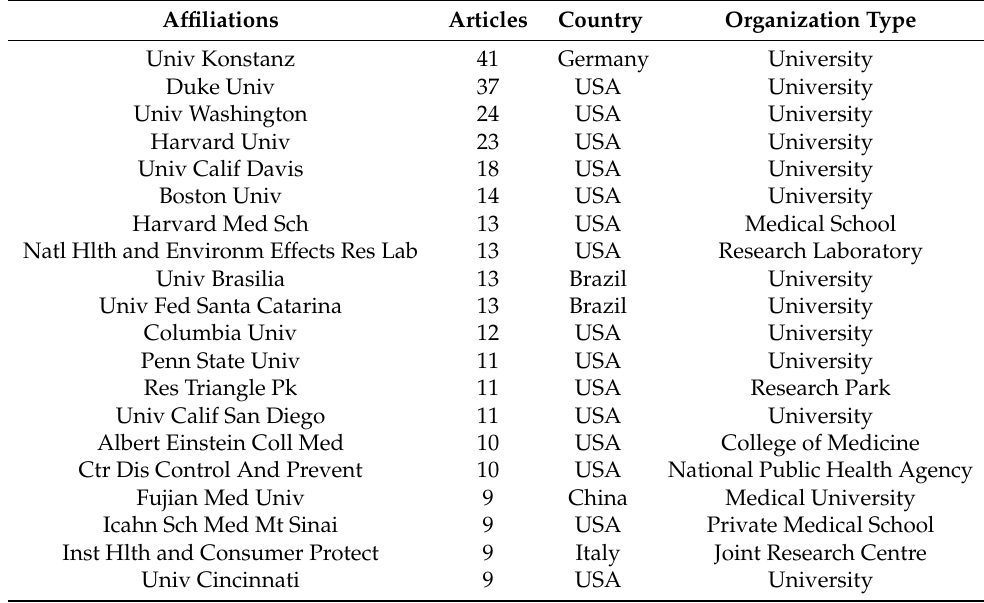
Table 3. Top 20 relevant organizations from 2011 to